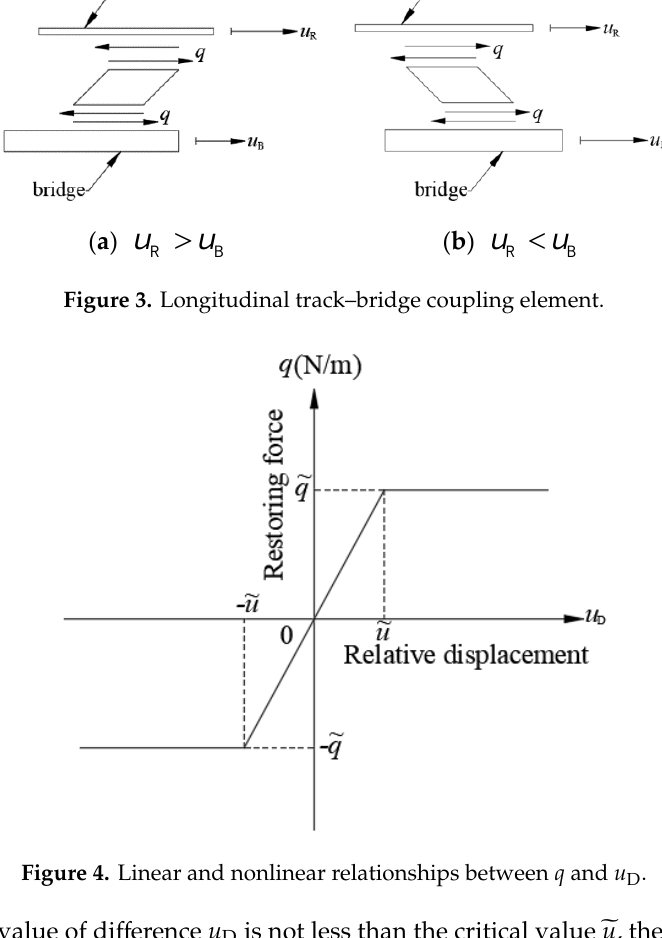
Figure 4. Linear and nonlinear relationships between